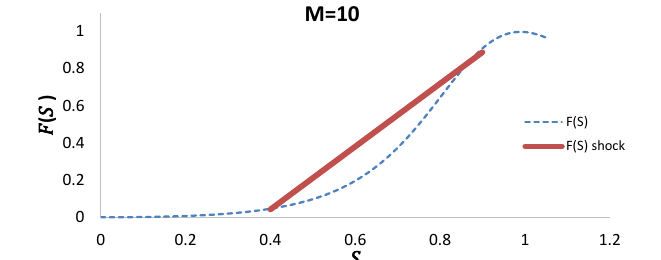
Figure 14. ( a ) The undercompressive shock for S l = 0.8, S r = 0.2, and ε = 0.05. The corresponding flux functions for three different mobility ratios ( b ) M = 0.3, ( c ) M = 2.5, and ( d ) M = 10. The influence of the characteristic time τ in Equation (66) on the shock pattern is small, as can be observed in Figure 15. The results presented here agree with the analytical solutions in [24]. Indeed, the shifting of the flux curve as the mobility ratio changes is reproduced. The shock propagation predictions agree with present results of our analysis as well.